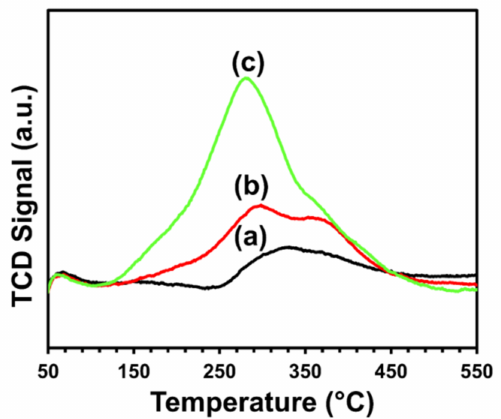
Figure 7. TPO profiles of ( a ) CeNiO 3 , ( b ) Ce 0.8 Sr 0.2 NiO 3 , and ( c ) Ce 0.6 Sr 0.4 NiO 3